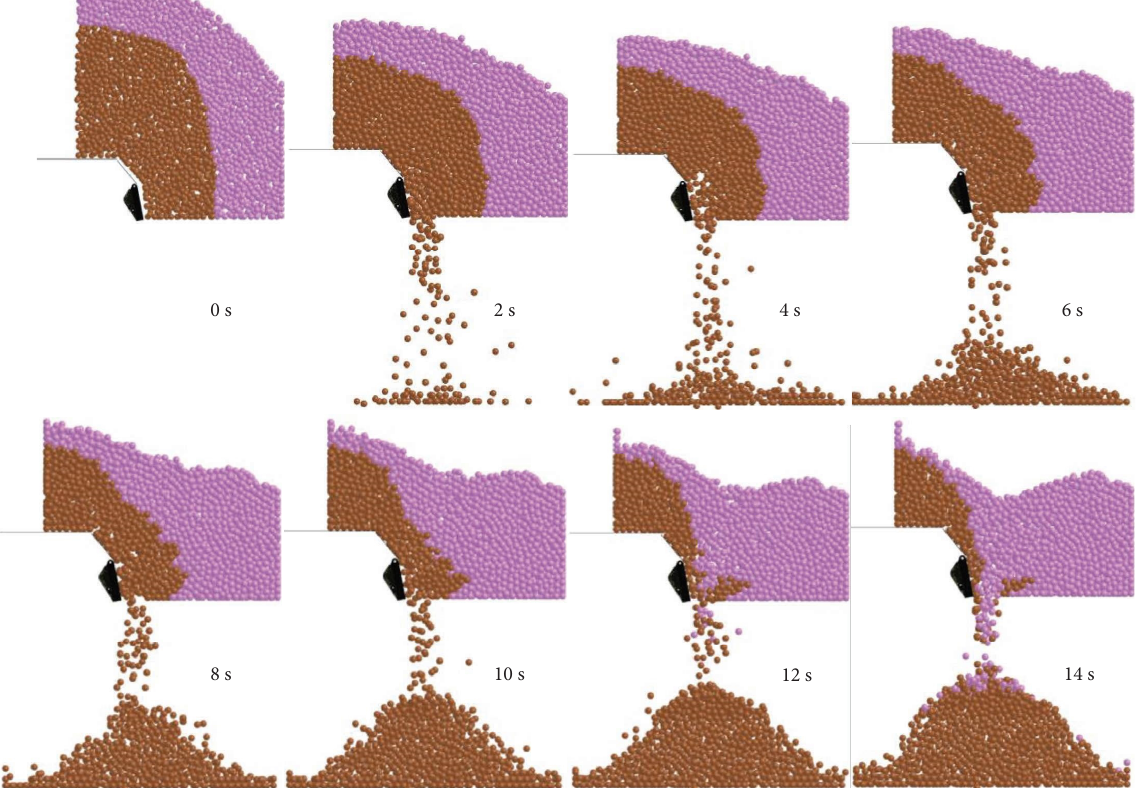
Figure 19: Te evolution of the coal-caving process at a 3.5m distance.